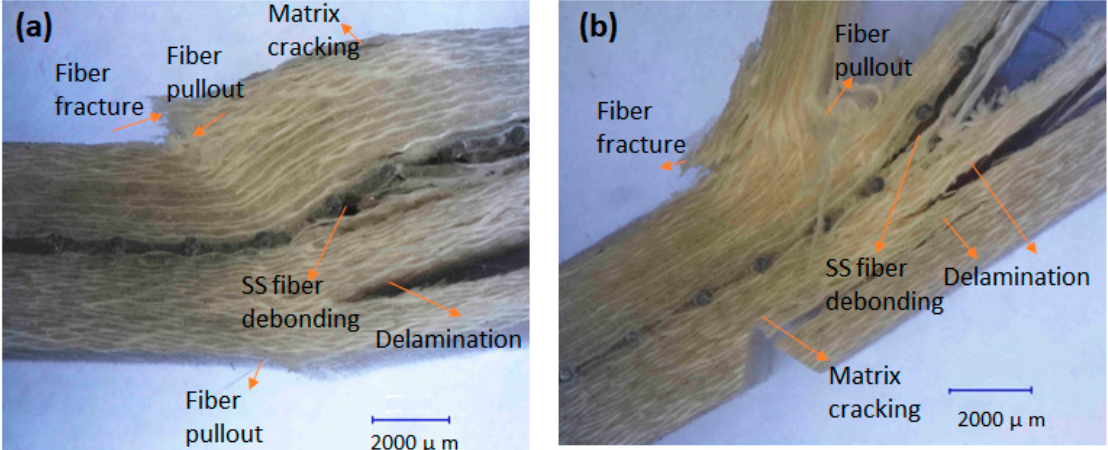
J. Compos. Sci. 2022 , 6 , x FOR PEER REVIEW Figure 15. ( a ) Unnotched SS/GFRP; ( b ) notched SS/GFRP. Figure 15. ( a ) Unnotched SS/GFRP; ( b ) notched SS/GFRP.